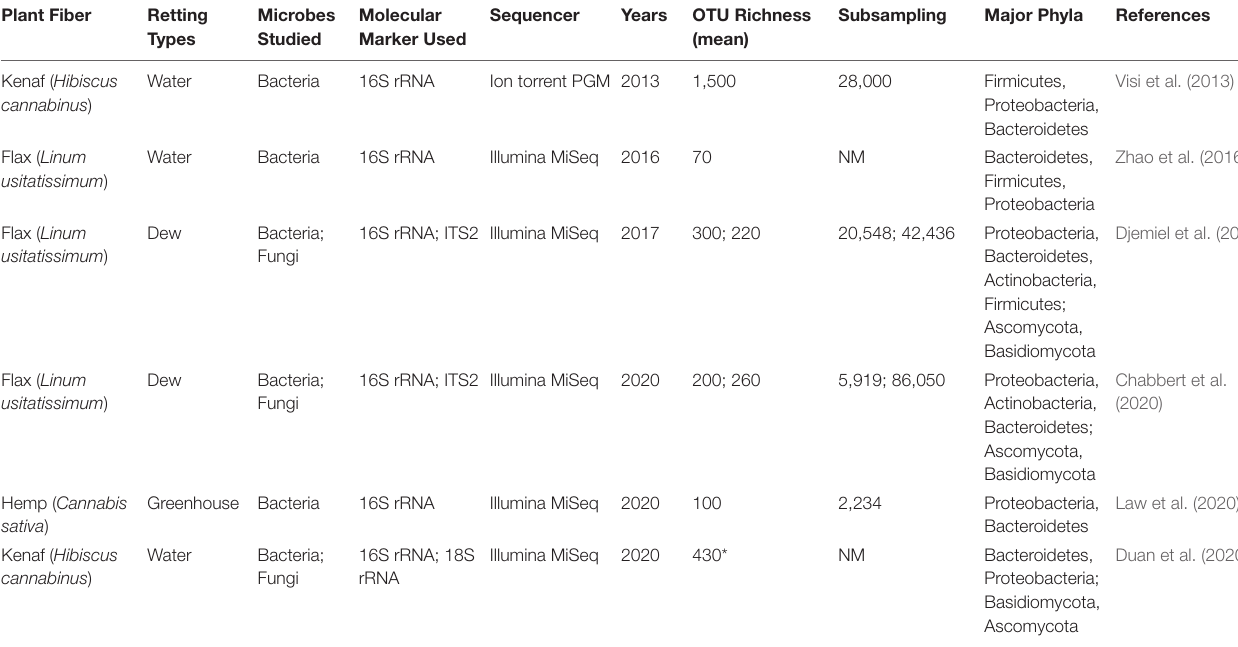
TABLE 3 | Non-exhaustive list of studies on the microbiology of retting performed using a metabarcoding